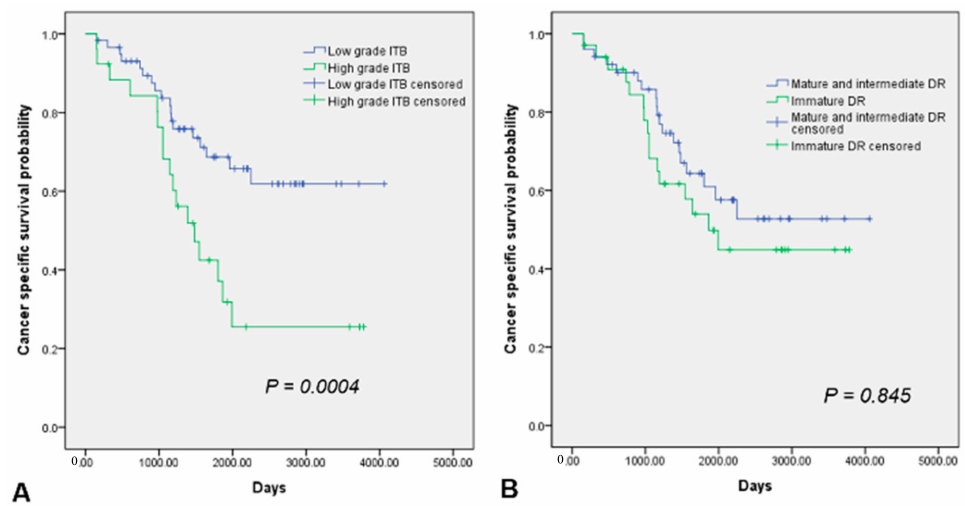
Figure 3. Cumulative cancer-specific survival (CSS) rates in patients with CRC with high and low intratumoral budding (ITB) grades ( A ) and desmoplastic reaction (DR) grades; p = 0.0004 for ITB grade ( A ) and p = 0.845 for DR grade ( B ).